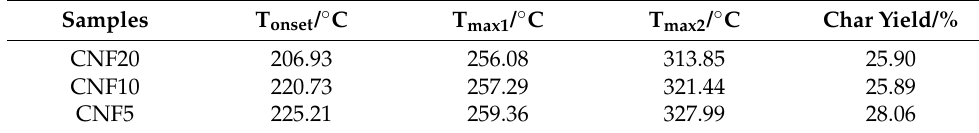
Table 1. TGA data of CNFs with different